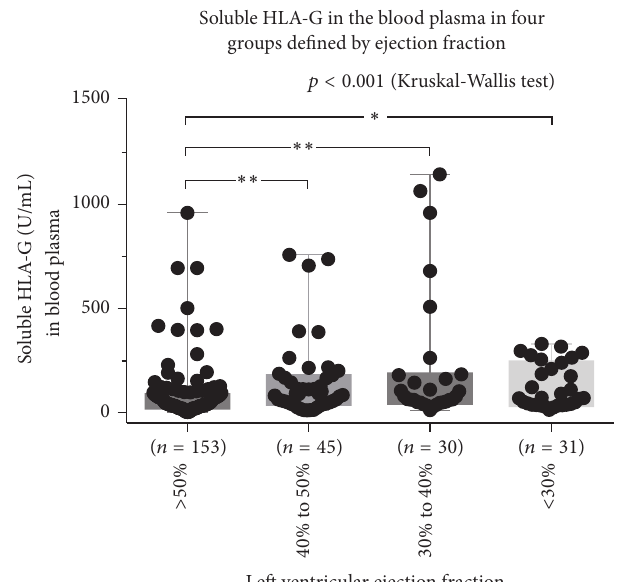
Figure 1: Soluble HLA-G in peripheral blood in relation to left ventricularejectionfraction(boxandwhiskersplot,min.tomax.,all points shown; 𝑝 < 0.001 , Kruskal-Wallis test; Dunn’s multiple com- parisons test, ∗ 𝑝 < 0.05 , ∗∗ 𝑝 < 0.01 ) (one NT-proBNP test failed in the group with ejection fraction > 50% reducing the number to